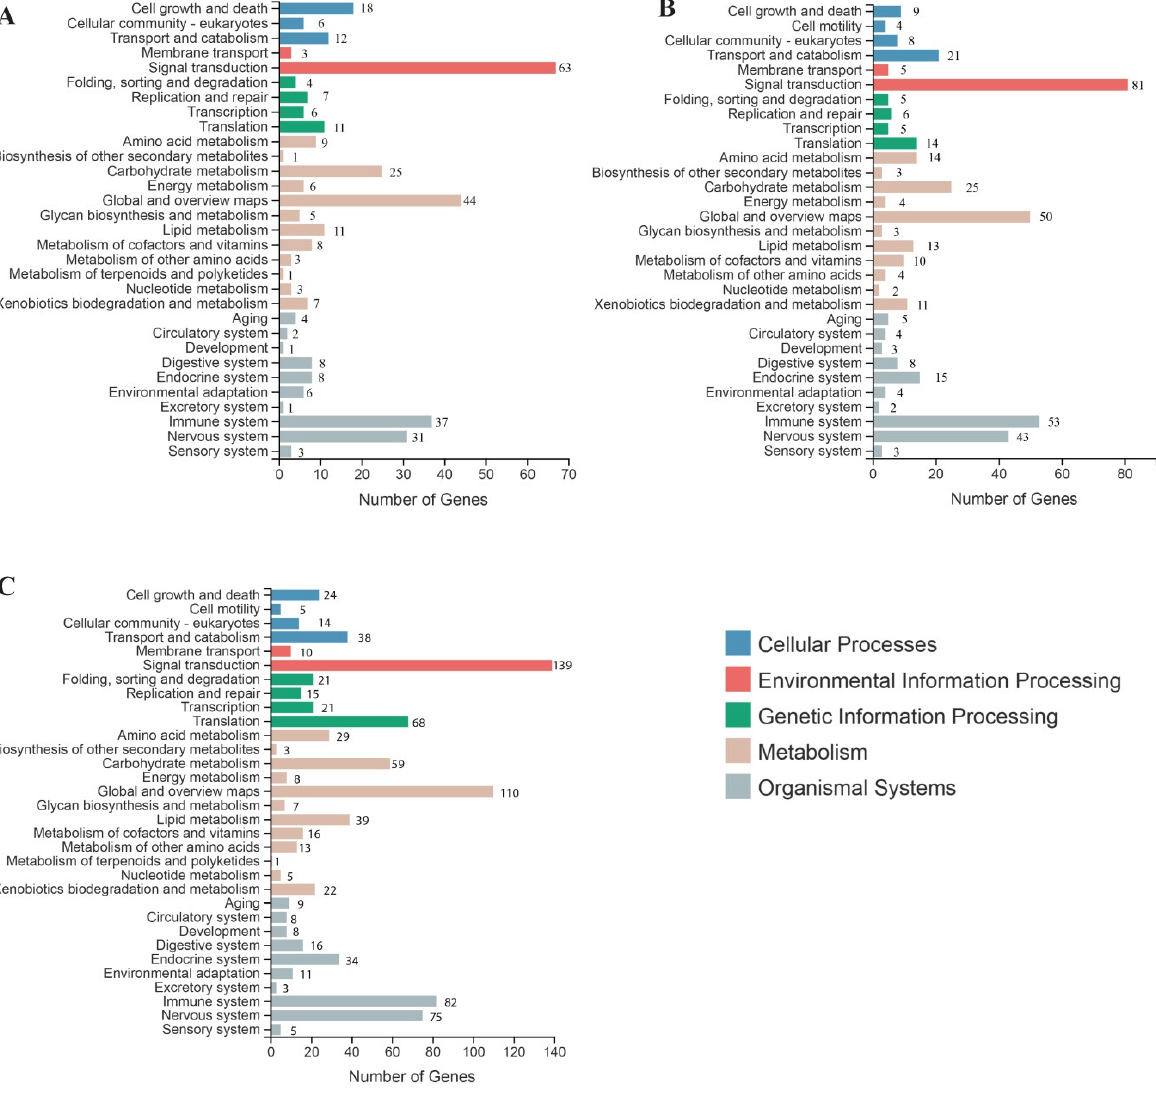
Figure 2. Kyoto Encyclopedia of Genes and Genomes (KEGG) analysis of specifically differentially expressed genes (DEGs) at 12, 24, and 48 h of MeJA treatment: ( A ) 12 h ‐ post treatment, ( B ) 24 h ‐ post treatment, and ( C ) 48 h ‐ post treatment.